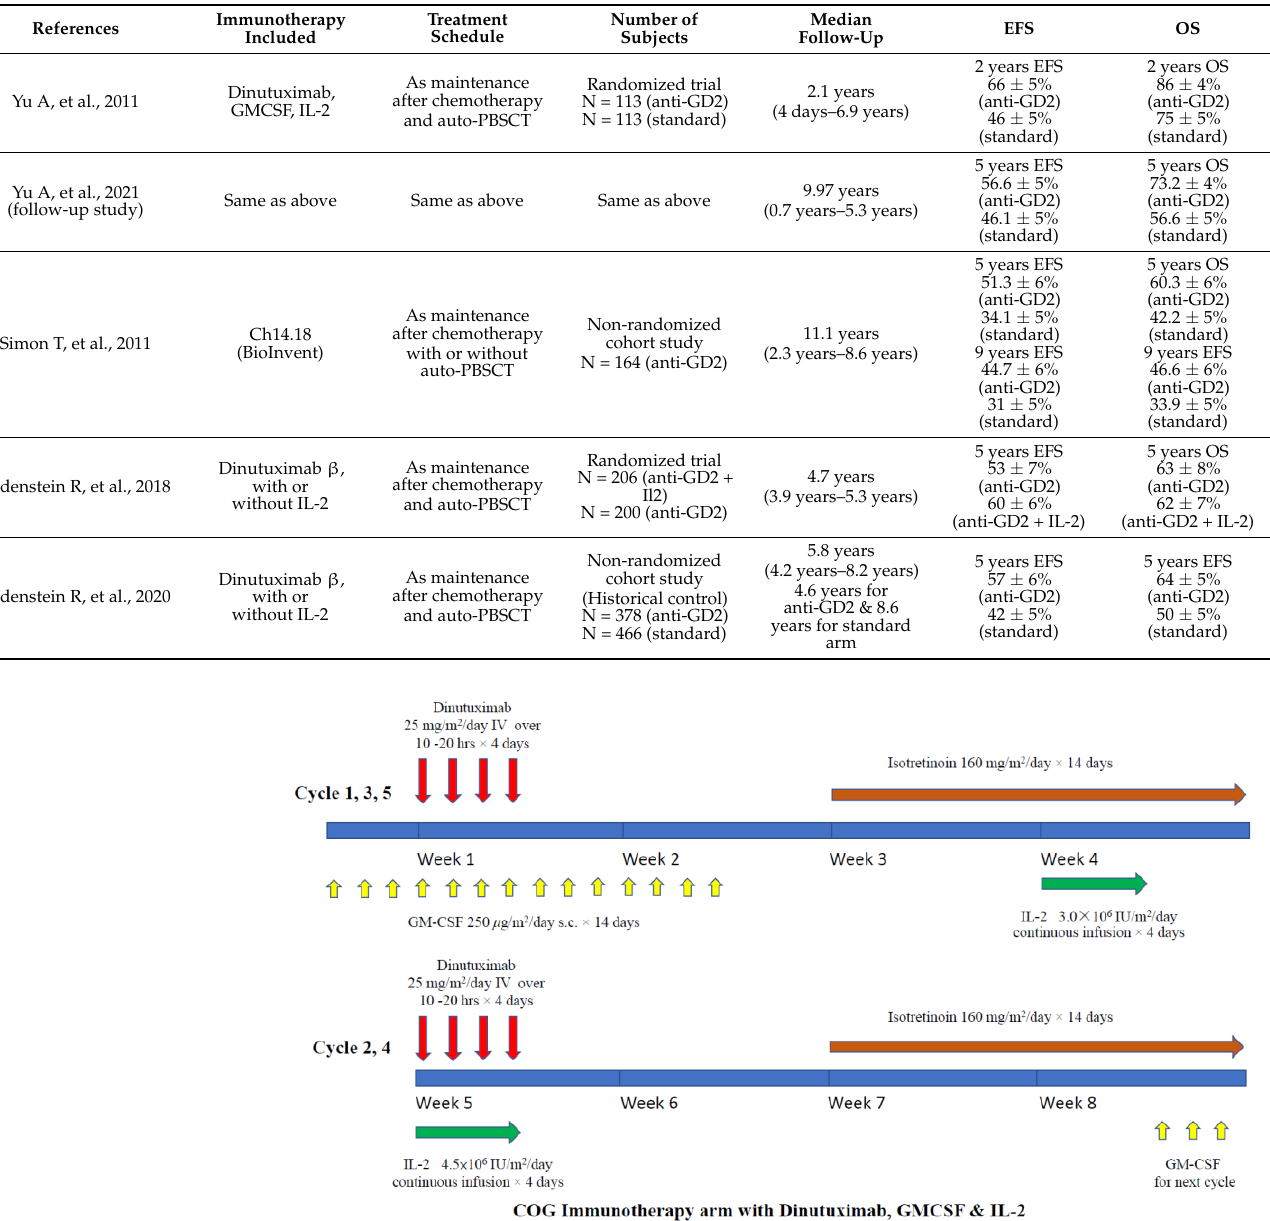
Table 1. Results of multi-center trials comparing anti-GD2 containing regimens with conventional treatments.